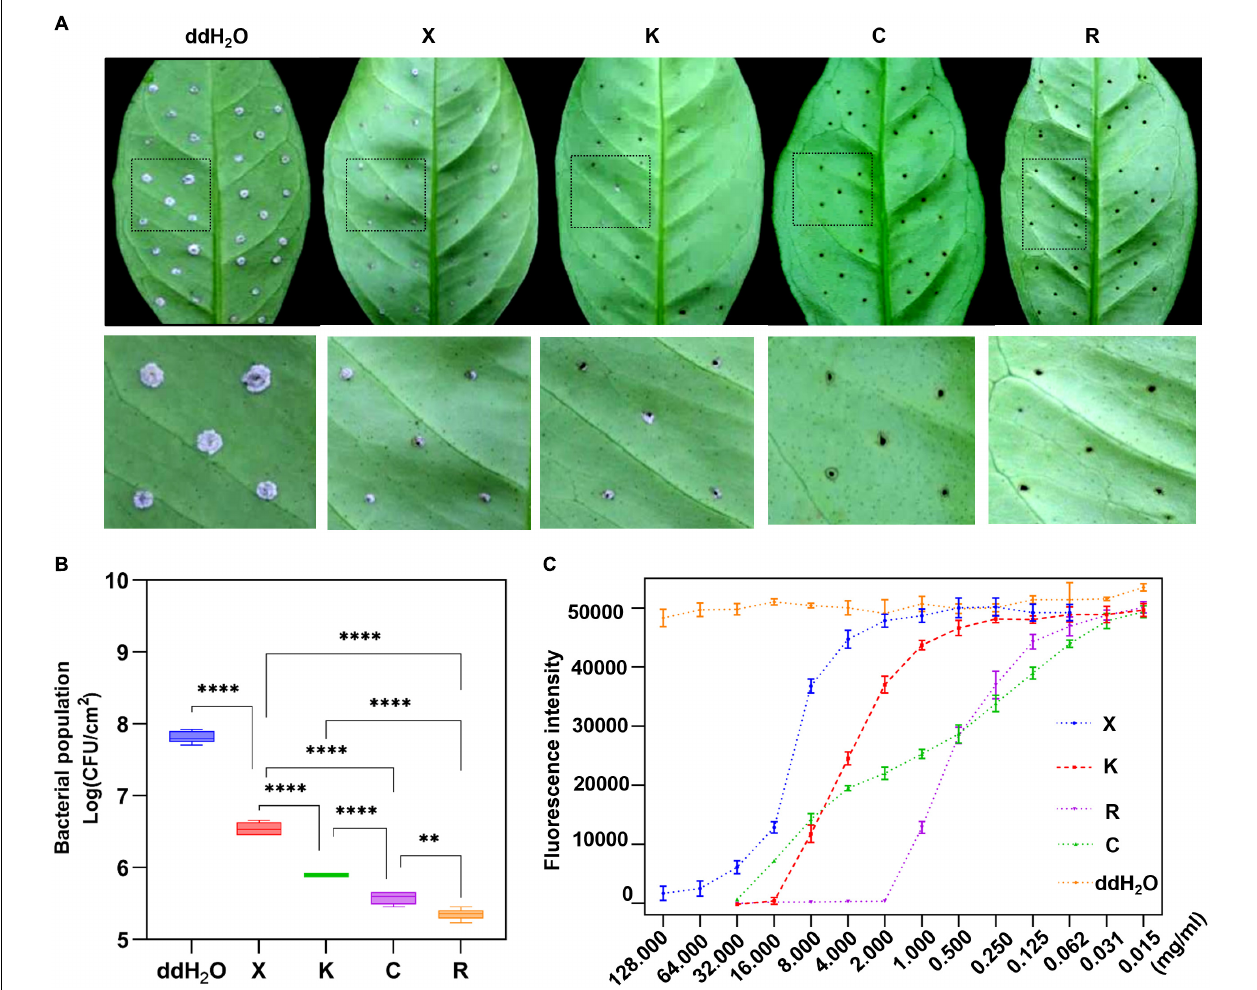
FIGURE 3 | Prevention effect and determination of minimum inhibitory concentrations (MICs) of four individual bactericides with the reporter-based assay. (A) After 7 days, the development of citrus bacterial canker (CBC) disease on citrus leaves pretreated with different bactericides was processed in the evaluation of the inhibition rate using the pinprick-inoculation method. (B) The result represents the bacterial population among different treatments using the fluorescence spot counting method to calculate the bacterial population of Xcc-eYFP at 7 days postinoculation. Experiments were repeated three times with similar results. Error bars are representative of the SD of the mean of five replicates. Statistical analysis was processed by two-way ANOVA following multiple comparisons with the Tukey’s test (95% CI) using GraphPad Prism 9 ( ∗∗ p < 0.05, ∗∗∗∗ p < 0.0001, nsP >0.05). X:1.2% xinjunan acetate (AS); K:33% kasugamycin xine-copper (SC); C:30% copper oxychloride (SC); R: 20% resin acid copper (EW); ddH 2 O: double-distilled water. K:33% kasugamycin xine-copper (SC); X:1.2% xinjunan acetate (AS); C:30% copper oxychloride (SC); R: 20% resin acid copper (EW); ddH 2 O: water. (C) After 6 h of incubation, the Xcc-eYFP expressing fluorescence intensity in four individual bactericides was captured under the SparkTM Multimode Microplate reader. The x -axis represents the concentration of the bactericides. The y -axis represents the fluorescence intensity. Means and SDs of nine replicates of a representative result are